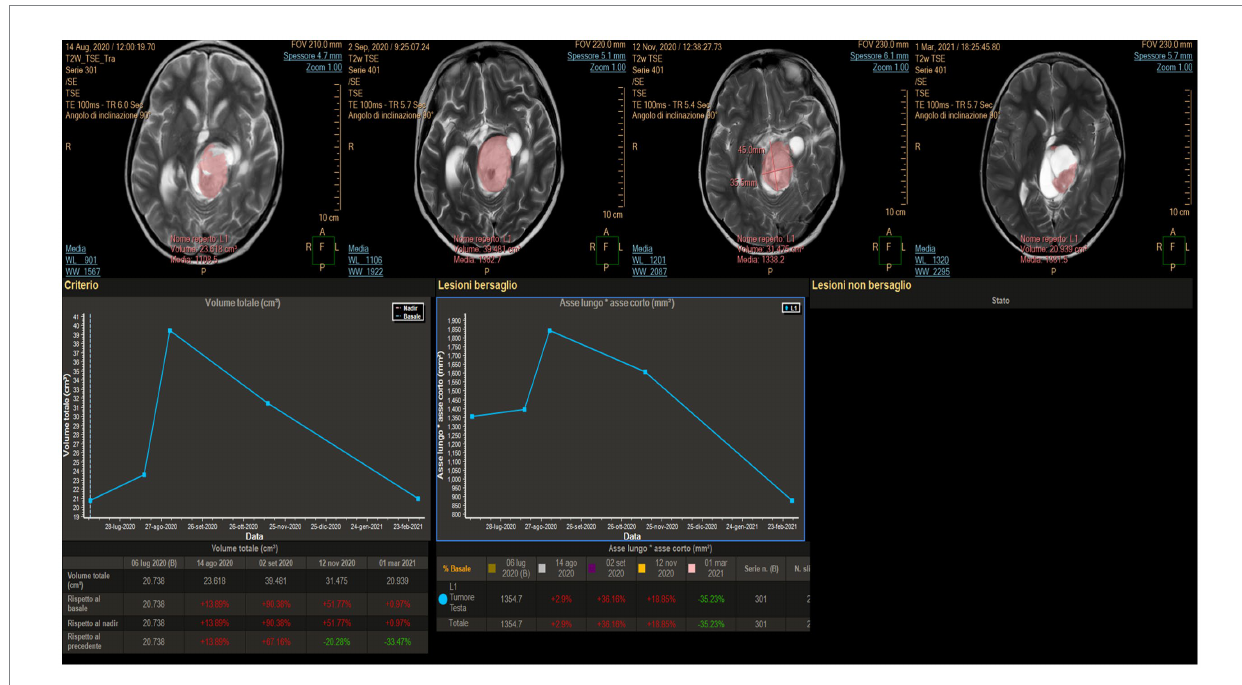
FIGURE 8 MITT Intellispace Portal imaging examination focused on the solid component of the tumor (case 2). Initially, after laser interstitial thermal therapy, the tumor appeared to increase in size due to edema, and the lesion looked different. However, a progressive reduction of the solid component by 33.5% occurred, with the ratio between the two main axes reducing by